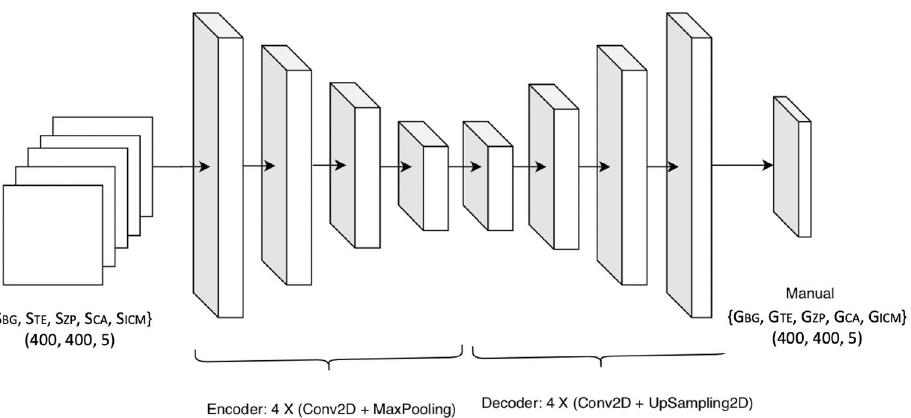
Figure 7. Depiction of the encoder-decoder architecture employed to refine the segmentation